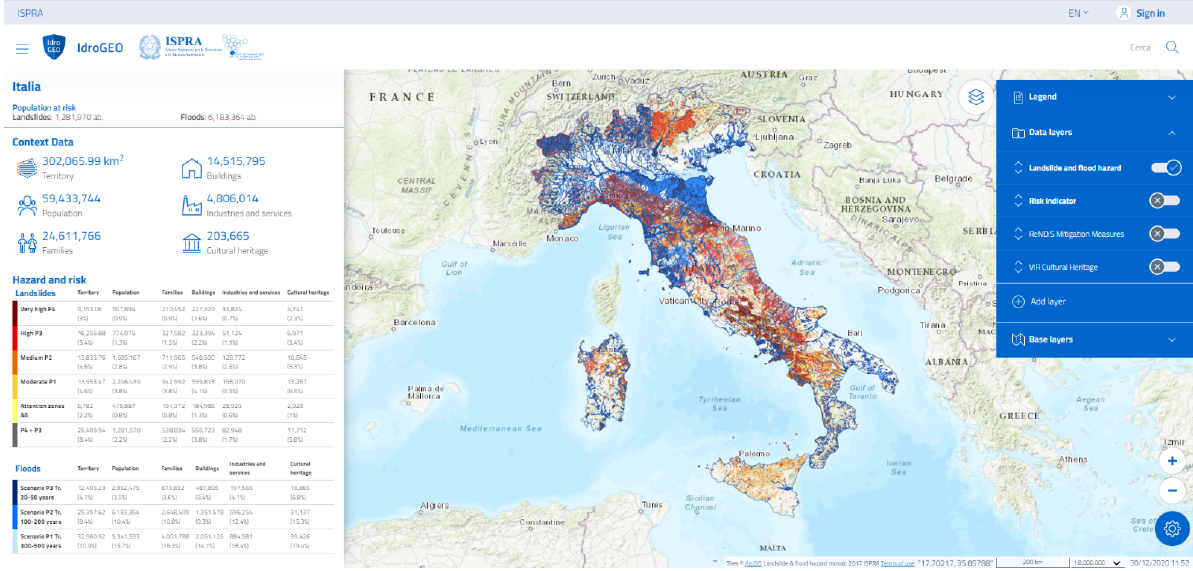
Figure 3. IdroGEO platform—landslide and flood hazard maps and risk indicators (HRI) section.